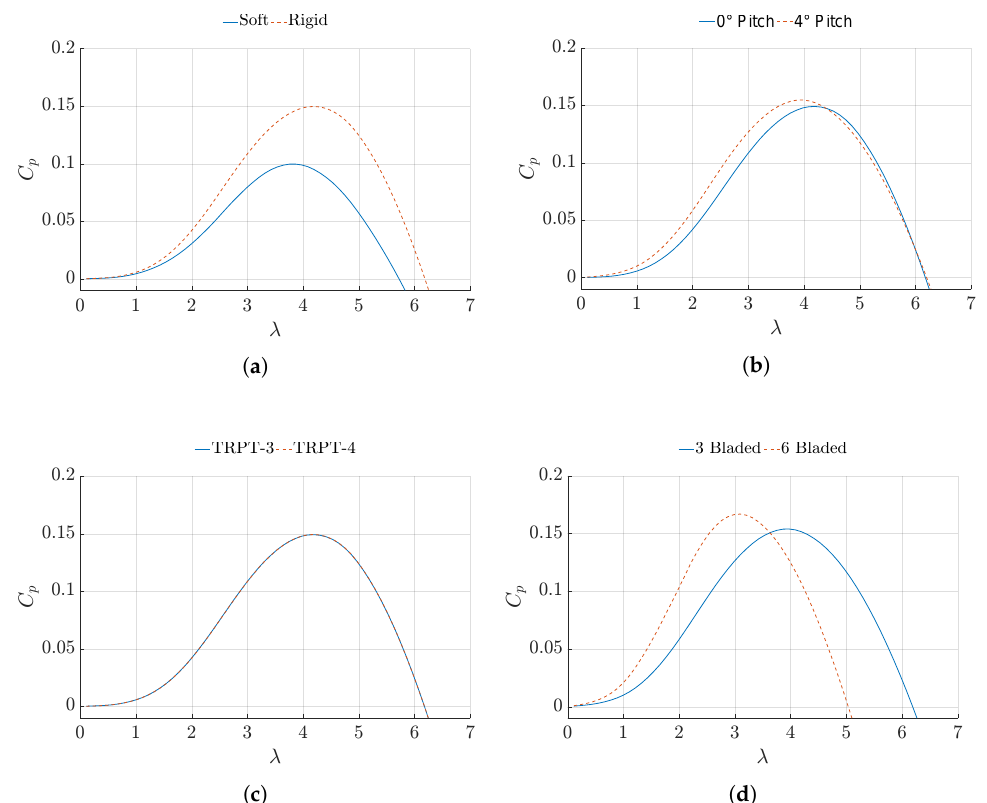
Figure 10. Steady-state power coefficient against tip speed ratio, Daisy Kite configuration compar- isons using spring-disc model. ( a ) Rigid and soft wings; ( b ) 4 ◦ & 0 ◦ pitched rigid wings; ( c ) TRPT–3 and 4; ( d ) 3 and 6